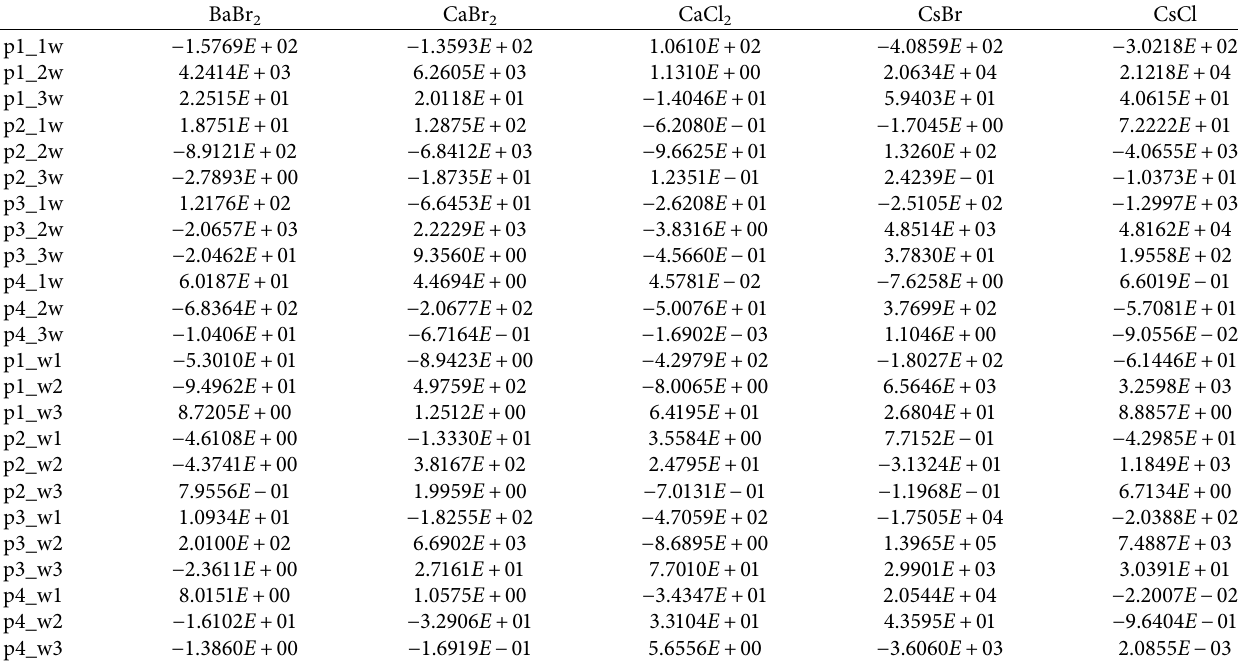
Table 1: Interaction parameters 1.